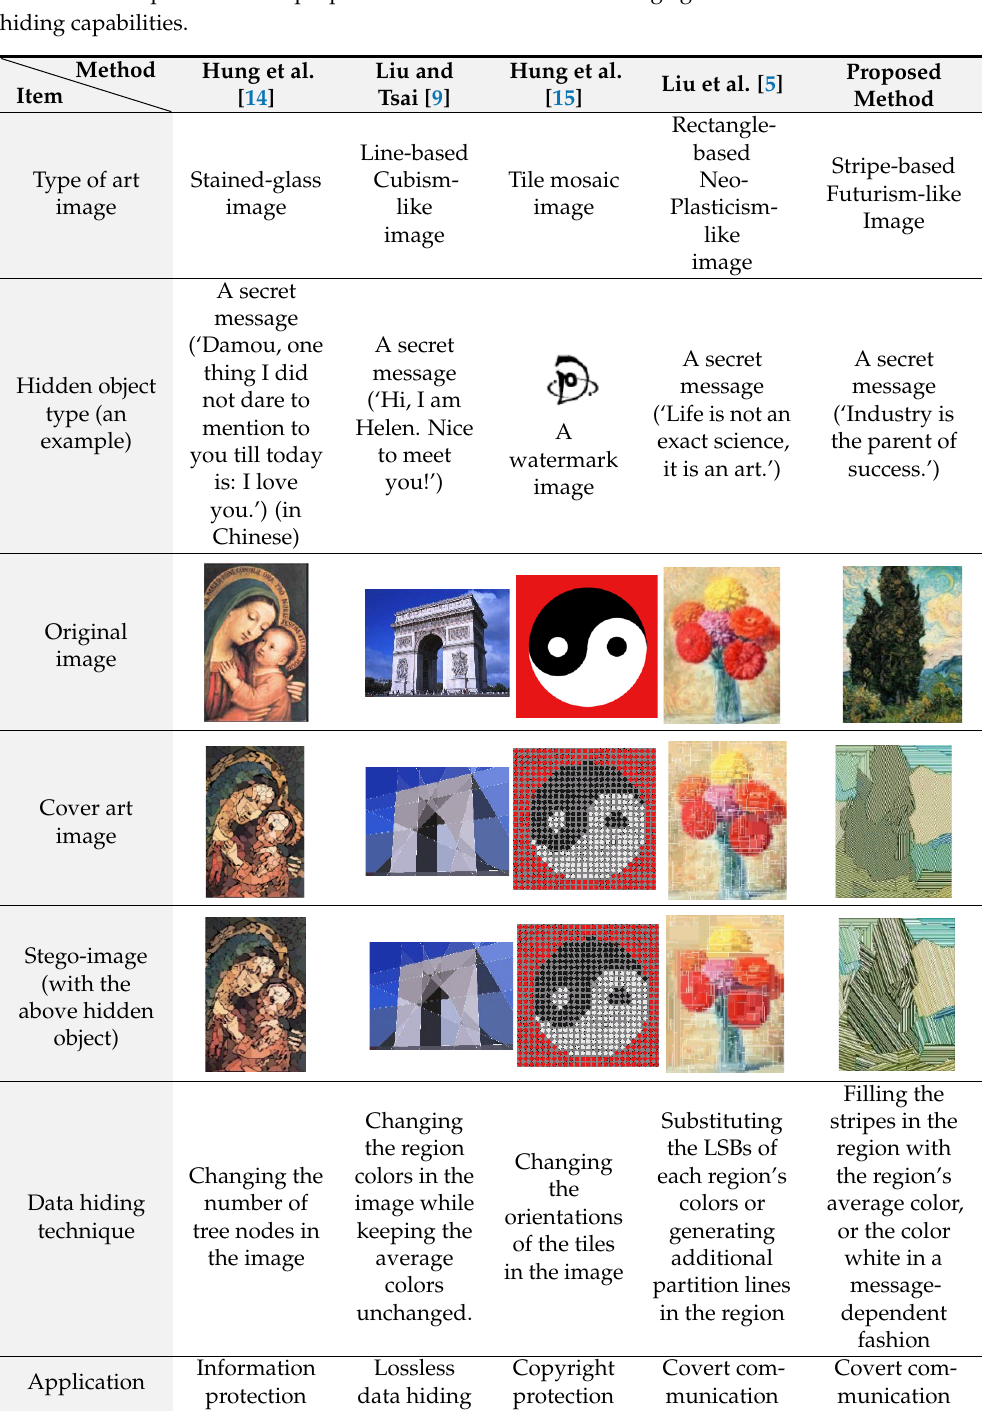
Table 5. A comparison of the proposed method with four art image generation methods with data hiding capabilities.